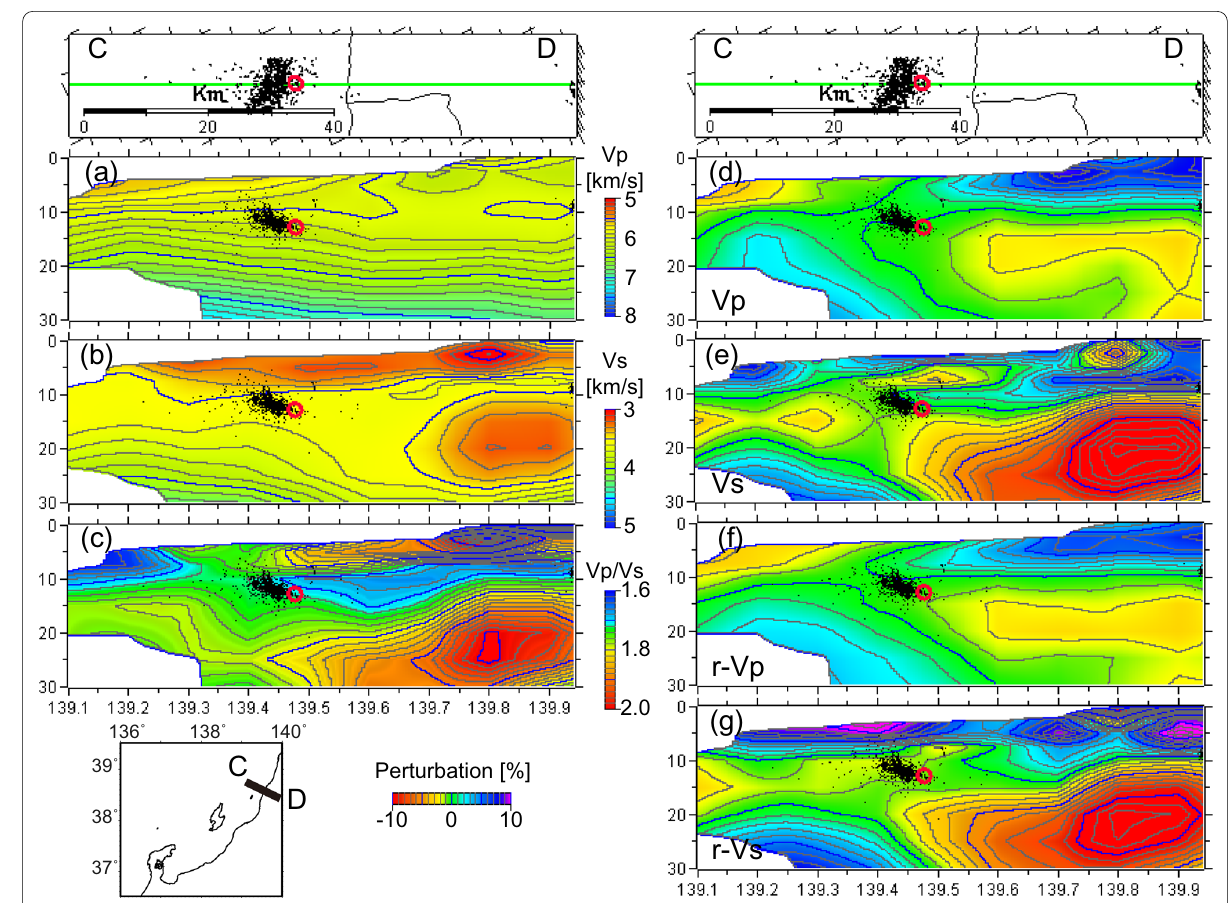
Fig. 17 WNW–ESE cross section of seismic velocity structure and restored resolution test around the 2019 offshore Yamagata earthquake. Red circles denote the hypocenter of the 2019 offshore Yamagata Earthquake determined with the 3D velocity